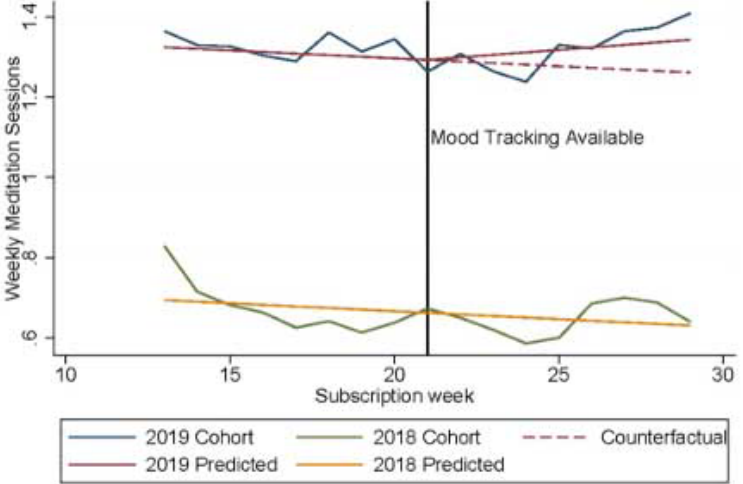
Figure 1. Average weekly meditation sessions for the 2018 and 2019 cohorts along with the estimated trend before and after the introduction of the mood check-in feature in October 2019.